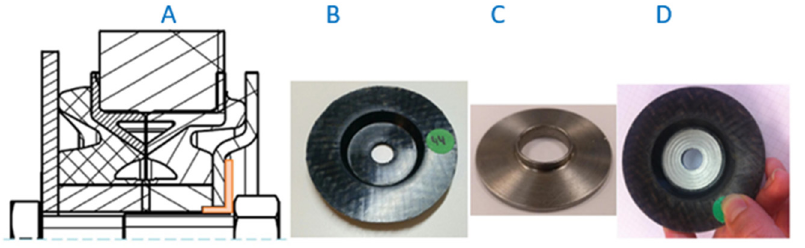
Figure 13. Prototype reinforced: ( A ) Assembly Drawing. ( B ) P6 FG45 sheet. ( C ) Steel insert reinforcement. ( D ) Reinforced sheet after fatigue test (200,000 cycles).